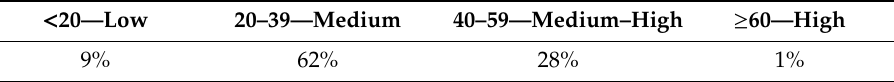
Table 1. Classification of respondents into financial risk attitude (FRA) classes.